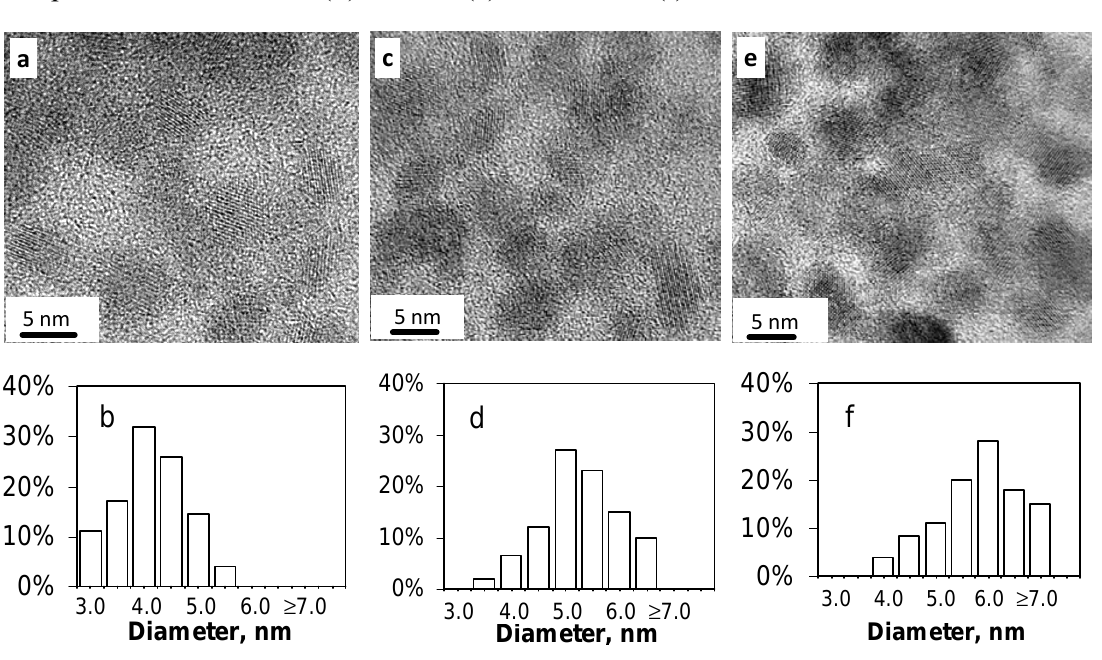
Figure 7. TEM images of SnS nanoparticles synthesized using 6 mL TEA at room temperature with further heat treatment at 100 °C for ( a ) 10 min, ( b ) 30 min, and ( c ) 60 min, respectively. The corresponding histograms of the size distribution for the SnS nanoparticles are shown in ( d ) 10 min, ( e ) 30 min, and ( f ) 60 min.